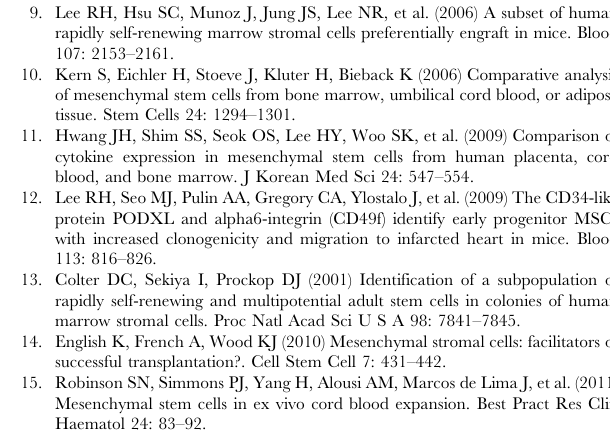
Table S1 List of genes that were differentially ex- pressed in MSCs harvested at high cell density (CC2 MSCs, , 90% confluence) relative to low cell density (CC1 MSCs, , 50% confluence) from three donors. Fold changes indicate gene expression differences between MSCs harvested at high cell density (CC2 MSCs, , 90% confluent) and at low cell density (CC1 MSCs, , 50% confluent). Viable second-passage AT-MSCs plated at 200 or 5,000 cells/cm2 were incubated for 7 days to approximately 50% confluence or 90% confluence, respectively. Positive values indicate higher expression and negative values indicate lower expression, in MSCs harvested at high cell density relative to low cell density. p , 0.05.